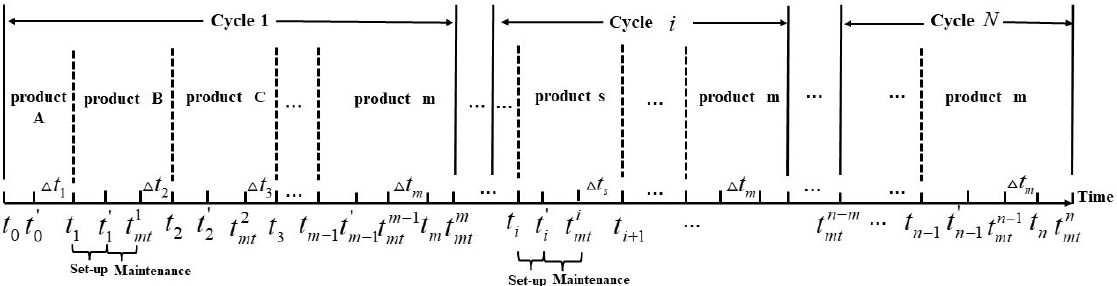
Figure 1. Production and maintenance